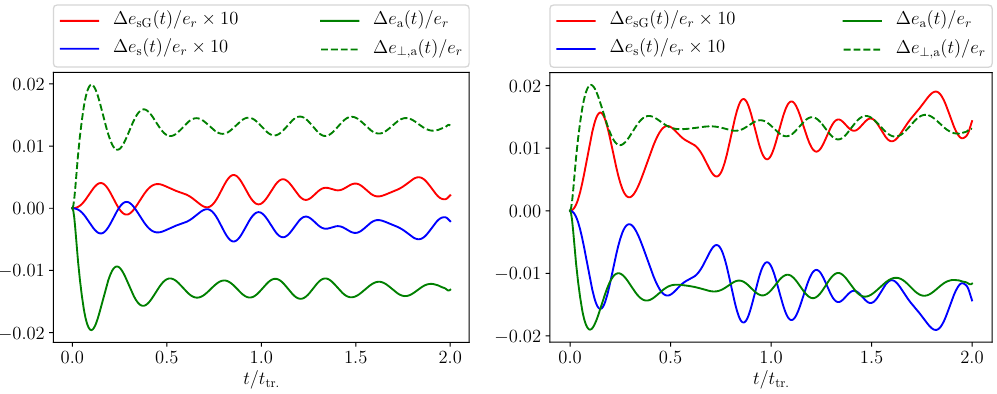
Figure 11: Energy flow between different terms in Eqs. (83), as a ratio with the = 〈 H ( 0 ) 〉 / L . Results are shown for the density profile from Fig. reference scale e r s 6(a), with σ = 1 (left panel) and σ = 2 (right panel).